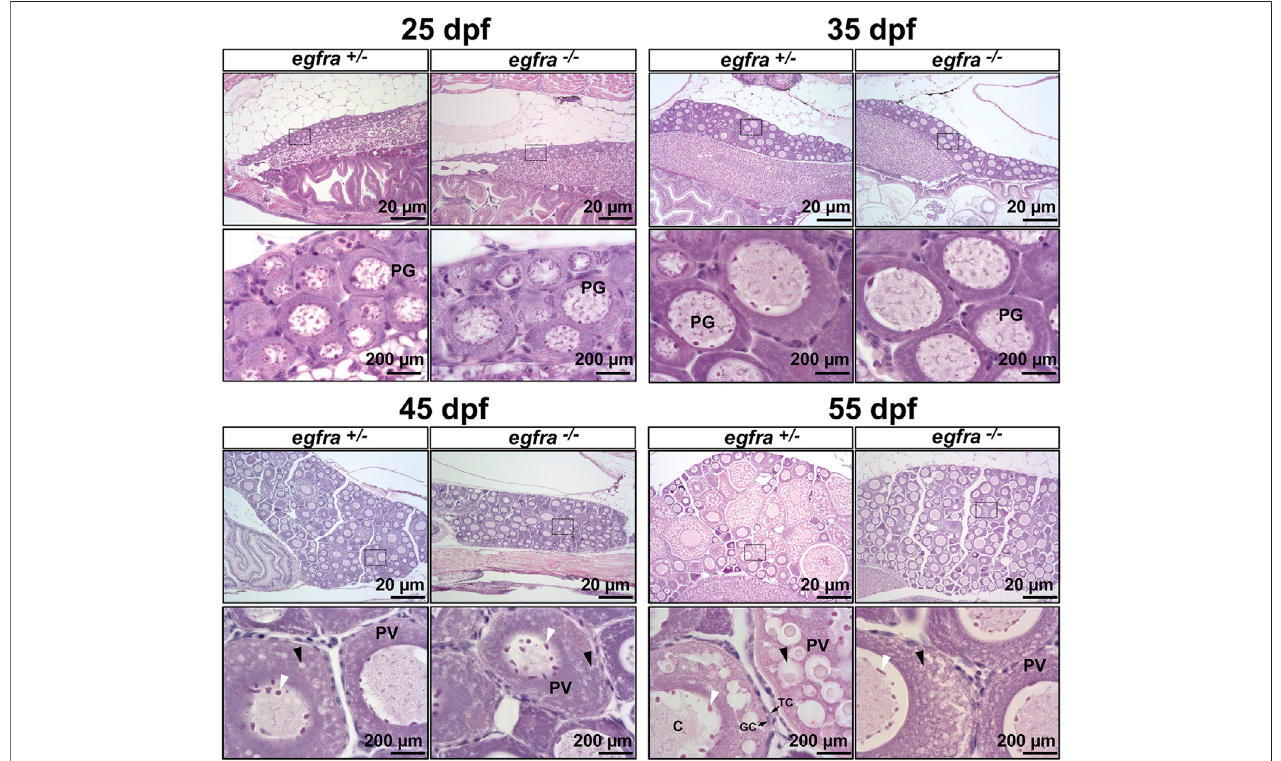
FIGURE 6 | Effects of egfra de fi ciency on folliculogenesis in juvenile fi sh ovary. At 25 dpf, the presumptive perinucleolar oocytes at PG stage could be seen in both control ( egfra +/ − ) and mutant fi sh ( egfra − / − ). These oocytes continued to grow in size in both genotypes at 35 dpf. At 45 dpf when puberty onset occurs in female zebra fi sh females, PV follicles with small cortical alveoli started to appear in the oocytes of both control ( egfra +/ − ) and mutant fi sh ( egfra − / − ). However, the PV follicles in the control continued to grow with increasing number and size of the cortical alveoli as seen at 55 dpf, whereas the growth ceased completely in the mutant with somefolliclescontainingrudimentalcorticalalveolionly.Six fi shweresampledateachtimepointforeachgenotype.PG,primarygrowth;PV,previtellogenic;blackarrow, cortical alveoli; white arrow, nucleoli at the periphery of the germinal vesicle; C, chromatin threads in the germinal vesicle; GC, granulosa cells; TC, theca cells.